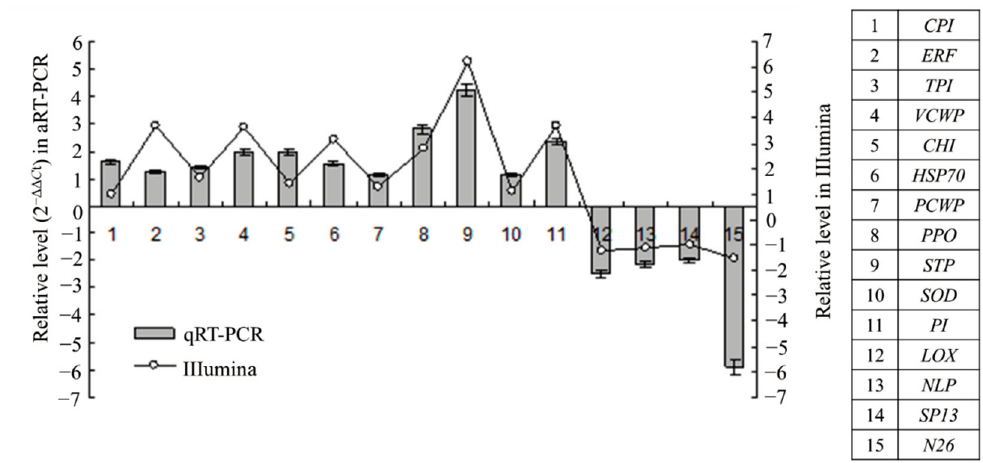
Figure 2. Validation of Illumina DGE results using quantitative real-time PCR (qRT-PCR) method. Data from qRT-PCR are means of three replicates and bars represent standerd error. CPI , cysteine protease inhibitor (Unigene11292); ERF , ethylene-responsive transcription factor (Unigene9043); TPI , trypsin inhibitor (Unigene19135); VCWP , vegetative cell wall protein (Unigene2183); CHI , chitinase (Uigene24094); HSP70 , heat shock protein